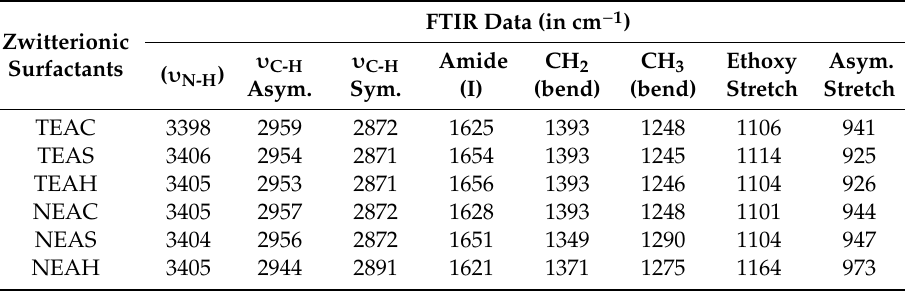
Table 3. FTIR data of the zwitterionic